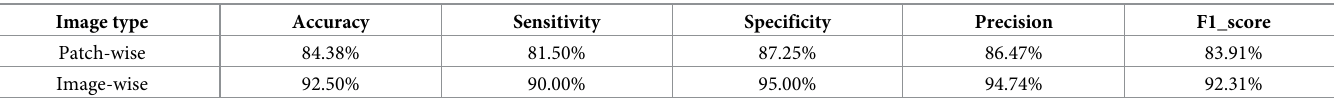
Table 10. Results on the ICIAR 2018 challenge